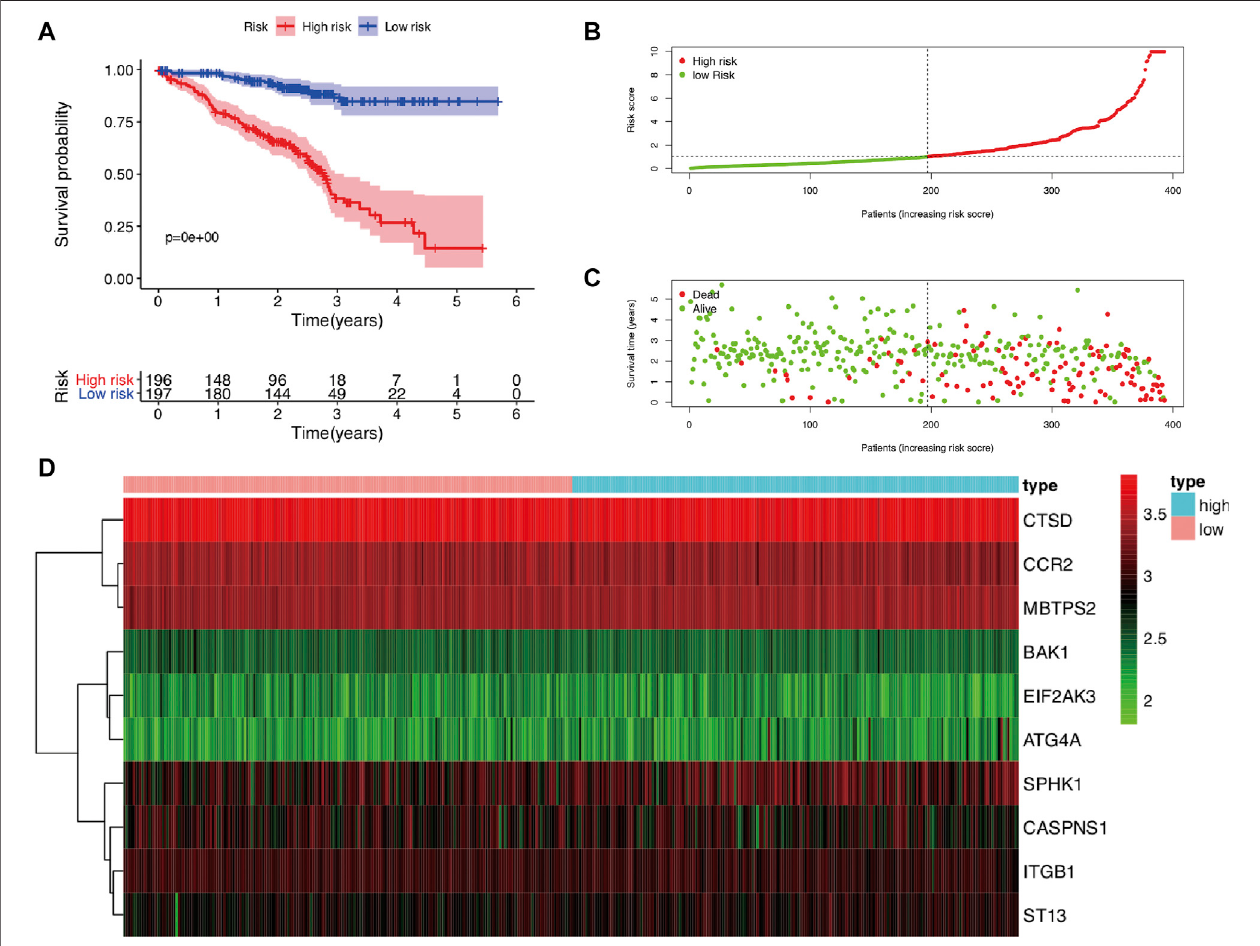
FIGURE 8 | The validation of the prognostic risk model based on ARGs in LUAD using an independent cohort GSE72094. (A) Kaplan – Meier analysis of OS between high-risk and low-risk groups in LUAD patients based on risk scores according to 10 ARGs signatures. (B) Visualization of the risk score plot of high-risk and low-riskgroupsinLUADpatients. (C) SurvivalstatuswasdisplayedinredandgreendotsbasedontheriskmodelastheriskscoreincreasinginLUADpatients. (D) Two- dimensionalhierarchicalclusteringofthesigni fi cant10differentially expressed prognostic ARGsinhigh-riskandlow-riskLUADpatients.ARGs,autophagy-related genes; lung adenocarcinoma; OS, overall